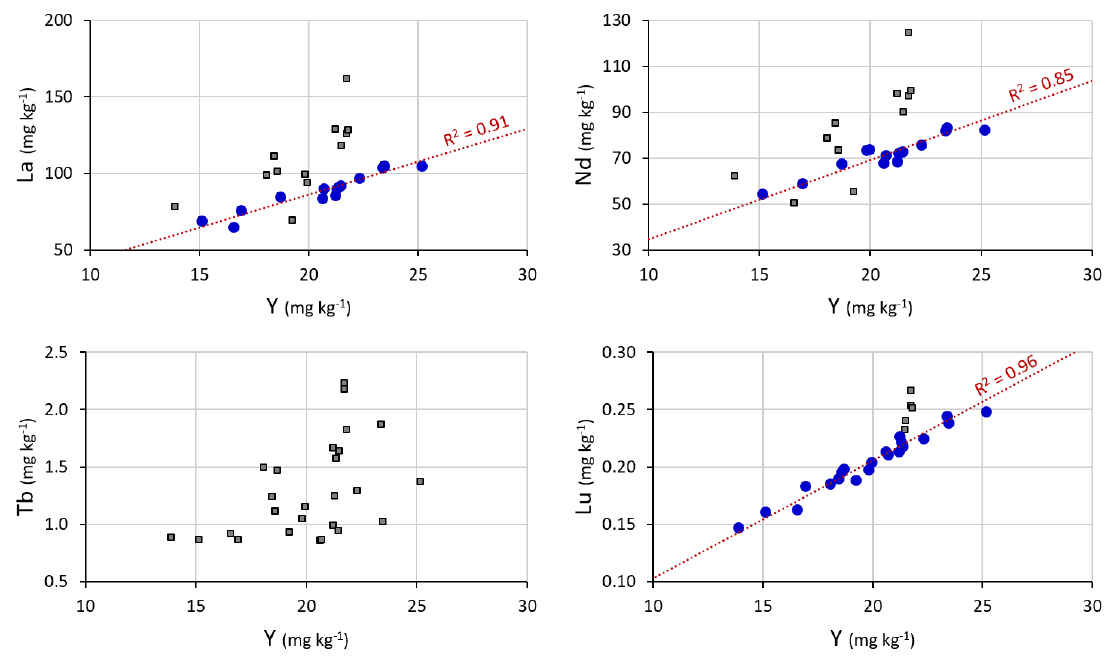
Figure 4. Examples of regression results (least squares simple regression with intercept = 0) between Y (independent variable) and lanthanoids (dependent variable). Blue dots are the samples included in the regression, gray squares are samples identified as unusual residuals, and the red dotted line is the regression model.